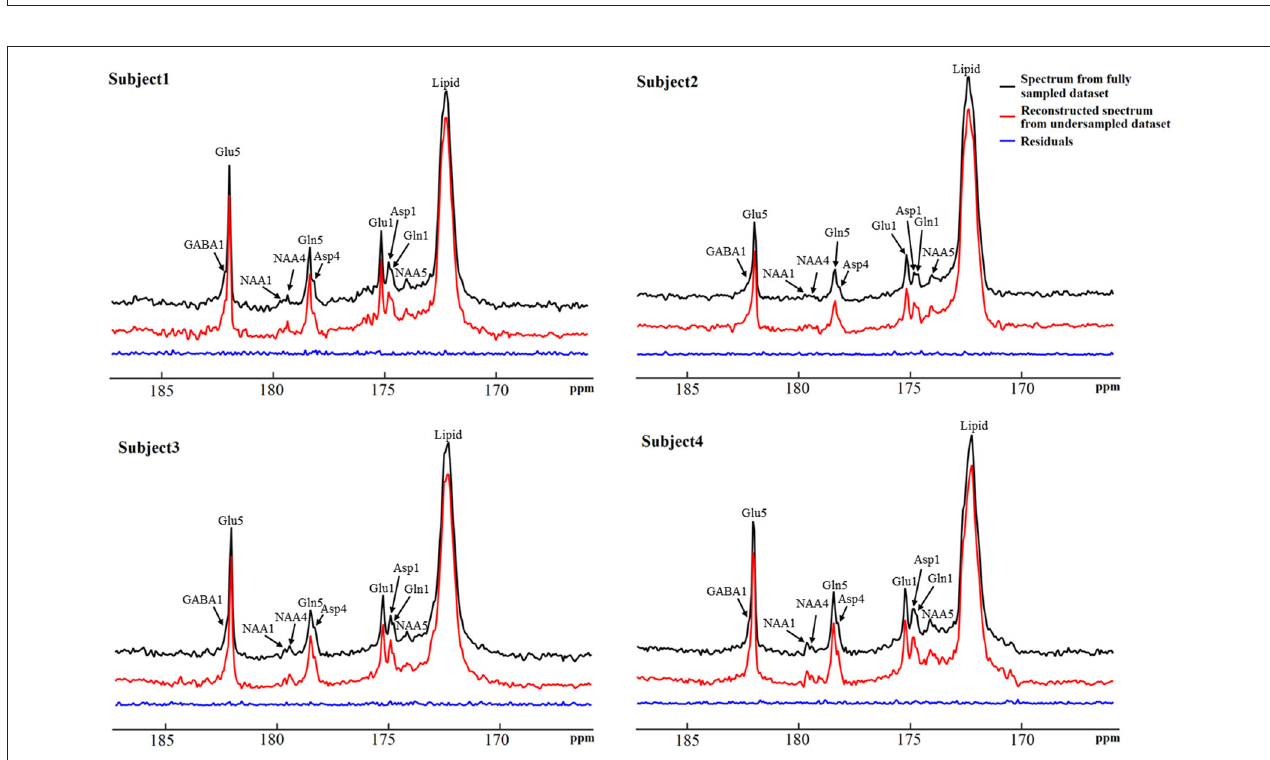
FIGURE 14 | Reconstructed in vivo 13 C MRS spectra from four healthy volunteers with under-sampling rate of 30%. Spectra from fully sampled data are displayed as reference. Acquisition parameters were: SW 5 kHz, data point 1,024, acquisition time 205 ms, NS 48, and TR 6s. Adapted from Li et al. [36].